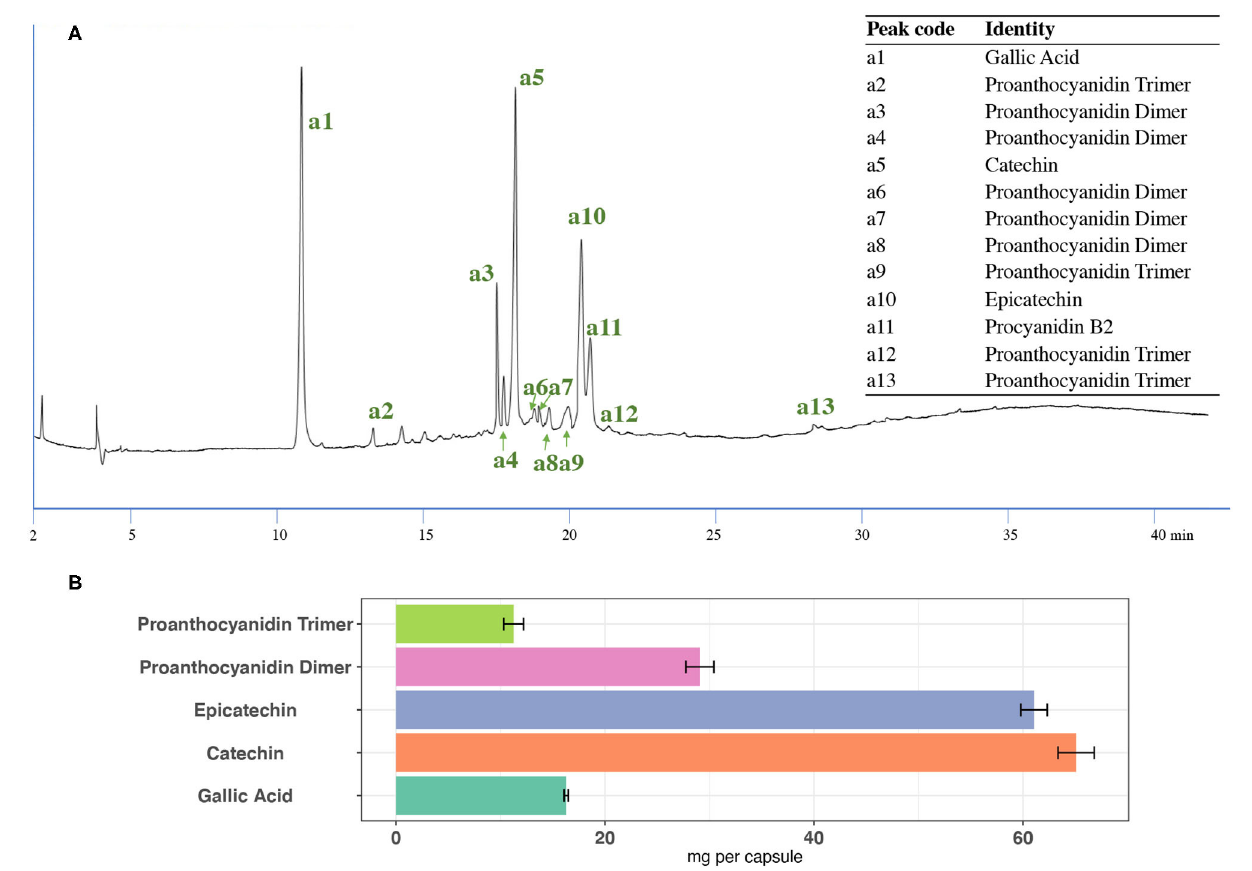
FIGURE 3 | (A) UV chromatographs of the Grape Seed Extract (GSE) capsule under 280nm and the tentative identifies and (B) the content of proanthocyanidin trimer, proanthocyanidin dimer, epicatechin, catechin, and gallic acid in the GSE capsule using the optimized extraction method.